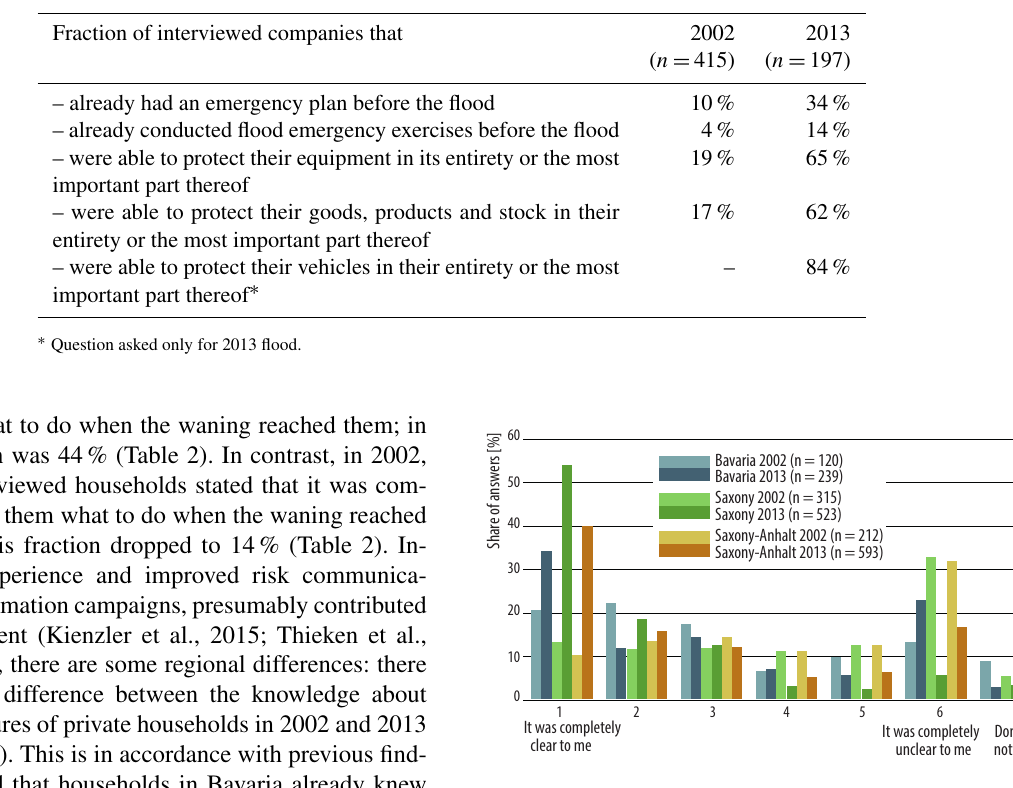
Figure 5. Answers of the households that had received a public au- thority warning, in response to the question whether they knew how to protect themselves and their household from the flood. Knowl- edge was significantly different ( p <0.05) between 2002 and 2013 in Saxony and Saxony-Anhalt (not in